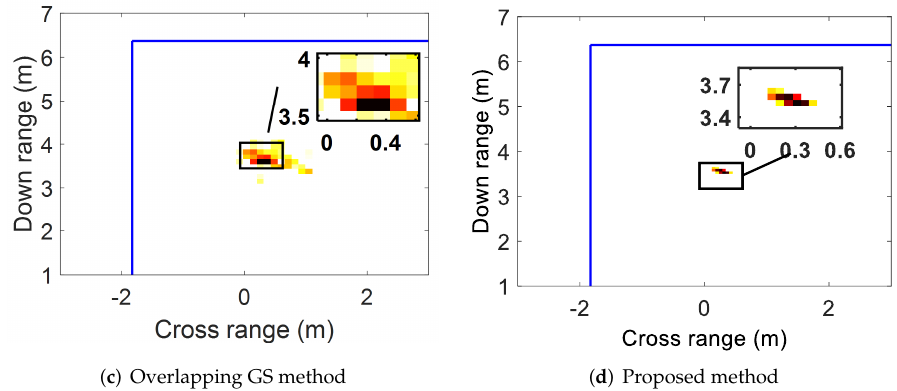
Figure 6. Comparison of reconstruction results in the experimental